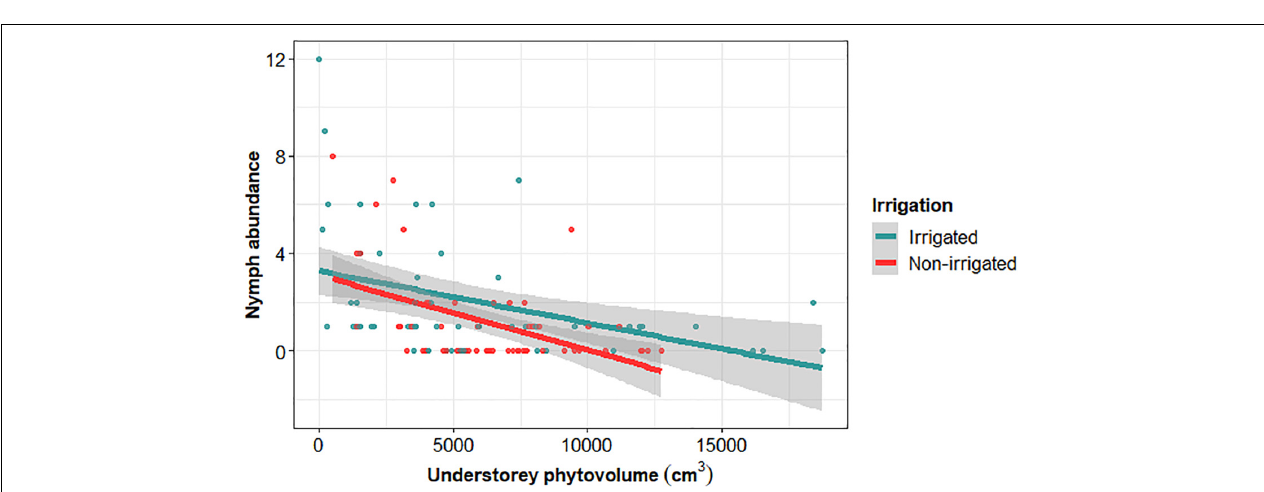
FIGURE 4 | Ixodes ricinus nymph abundance as a function of canopy tree density and irrigation in the plot. Canopy tree density is the ratio of the number of birch and/or pine trees to 100 total trees in the plot. Solid lines and gray shaded area correspond to the regression line and its 95% confidence interval, calculated on raw